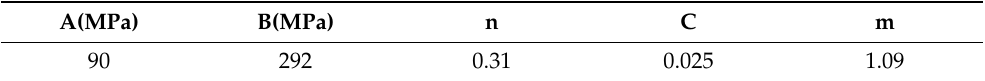
Table 3. Parameters of the J–C constitutive law for the Cu workpiece used in the FE model [18].